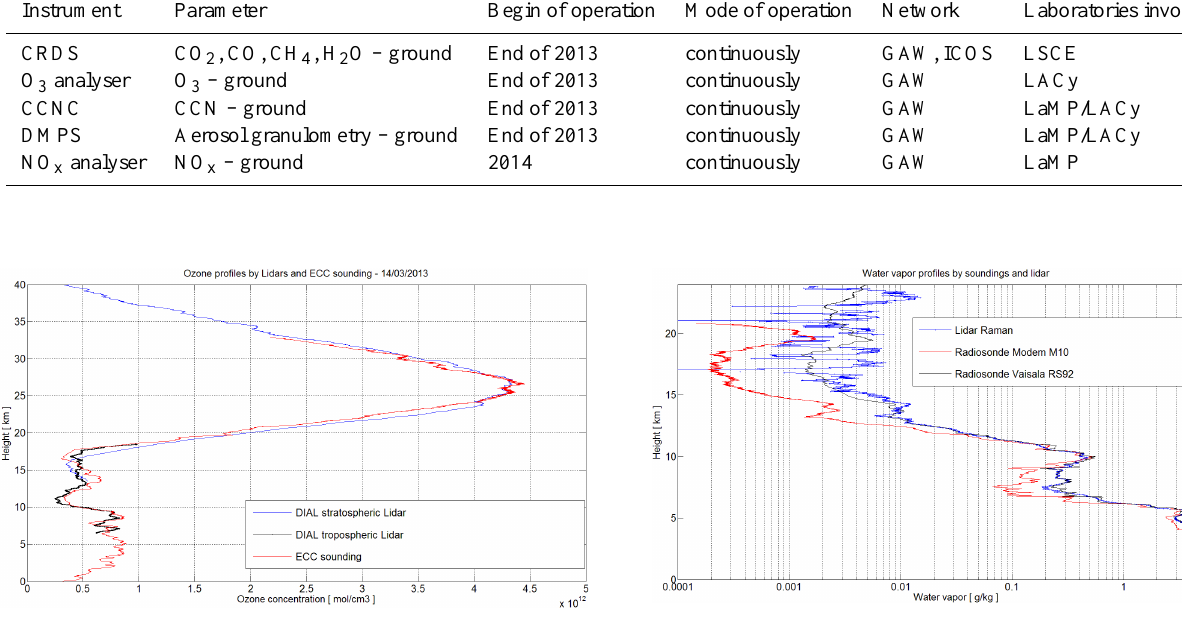
Fig. 5. Raman water vapor profile obtained at Maïdo observatory on 8 April 2013 (integration time: 1h), intercompared with simultane- ous M10 Modem and RS92 Vaisala radiosondes. The lidar profile has been calibrated with the RS92